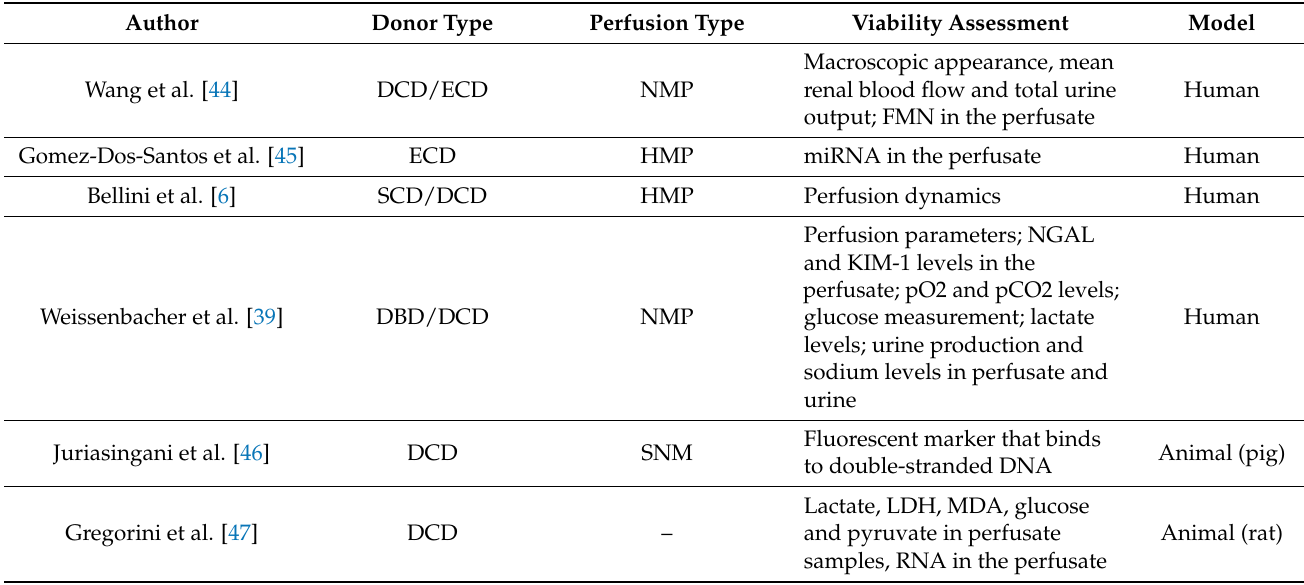
Table 1. Viability assessment parameters during ex situ Machine Perfusion. Legend: AAP: alanine aminopeptidase; ATP: Adenosine triphosphate; DBD: donor after brain death; COR: controlled oxygenated rewarming; DCD: donor after cardiac death; ECD: extended criteria donor; FABP: fatty acid binding protein; FMN: Flavin mononucleotide; GFR: glomerular filtration rate; GST: glutathione S-transferase; HMP: hypothermic machine perfusion; H-FABP: heart-type fatty acid